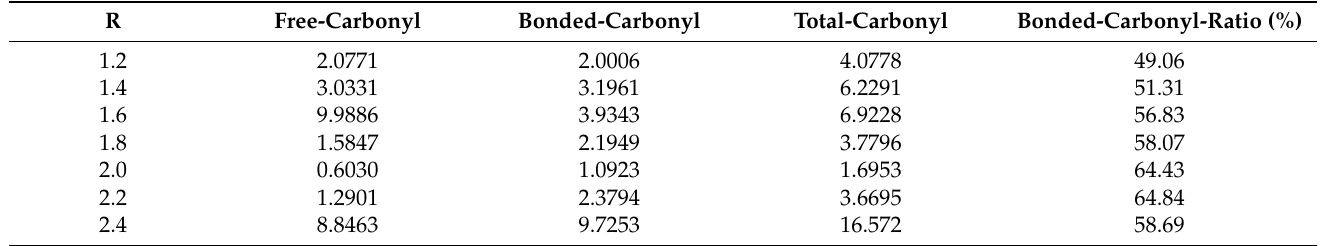
Figure 3. ( a ) FT − IR spectrum of carbonyl group of polymer fi lms with di ff erent R; ( b ) FT − IR peak fi tt ing spectrum of carbonyl group of polymer fi lms. Table 2. The bonded carbonyl ratio of GAP/TDI/GLY polymer fi lms with di ff erent R.